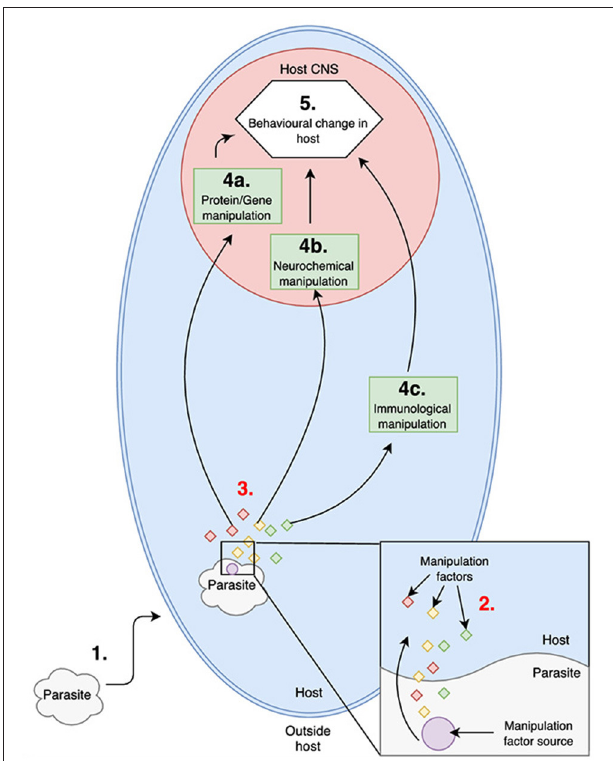
FIGURE 3 | Depiction of the known (1,4,5) and hypothetical (2,3) major steps in a parasite manipulating host behavior adaptively. Key: Numbers represent known and potential (highlighted in red) major fundamental steps in host